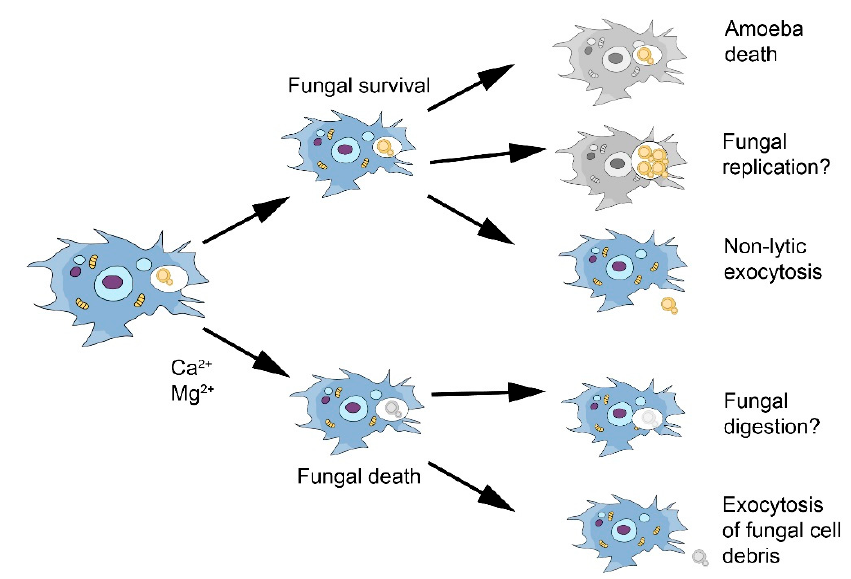
Figure 2. Scheme of known and possible interactions of C. neoformans with amoeba based on the experience with Acanthamoeba castellanii . The outcome of the interaction is highly variable and determined by such variables as the nutritional state of amoeba and the presence of metal cations in the media [45,46]. Question marks are added to processes for which there is uncertainty and/or that have not been demonstrated experimentally.